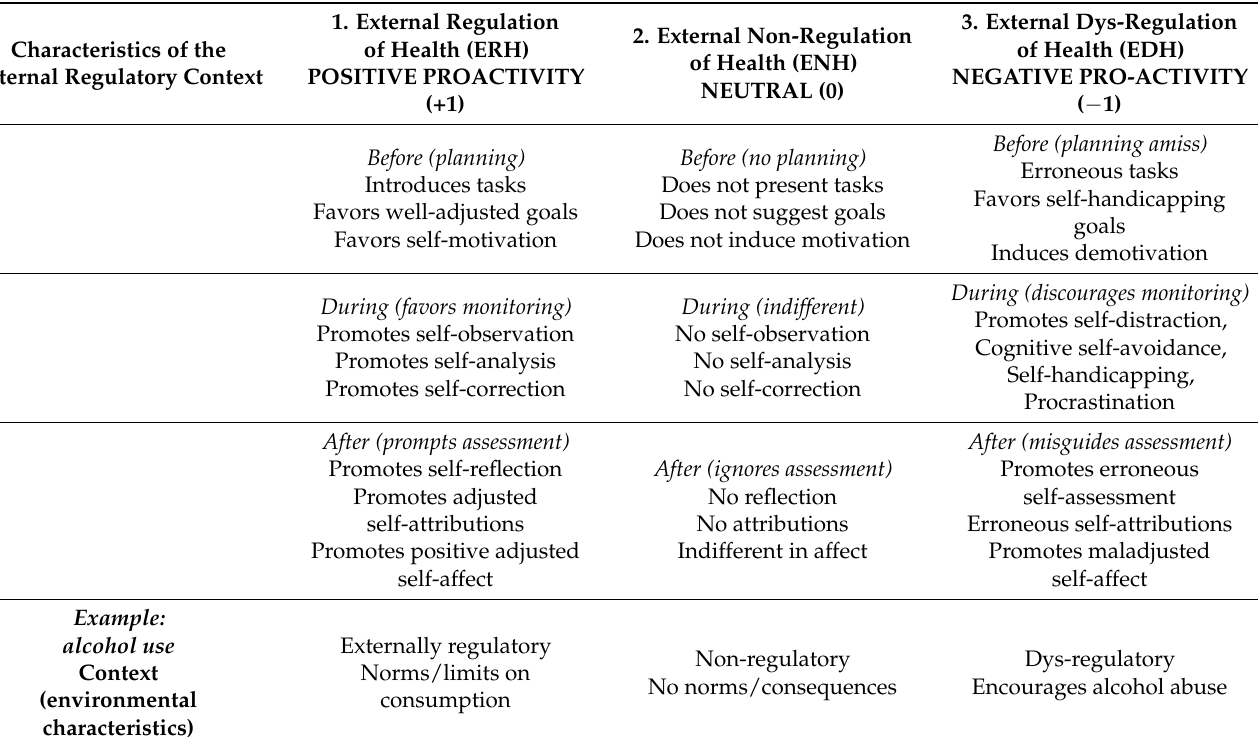
Table 2. Conceptual continuum of external health